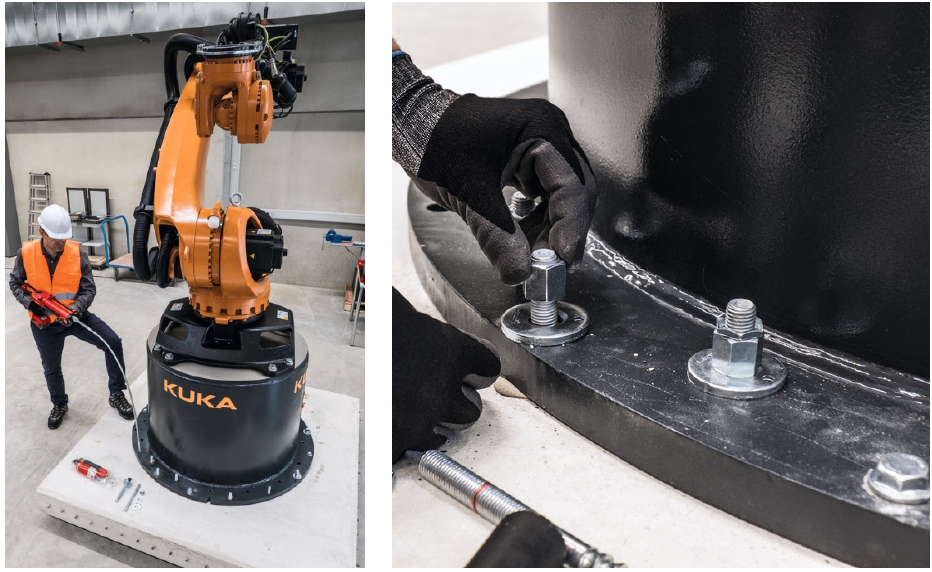
Figure 2. Using an anchorage to fasten the engineering equipment to the reinforced concrete bearing structures of a building.